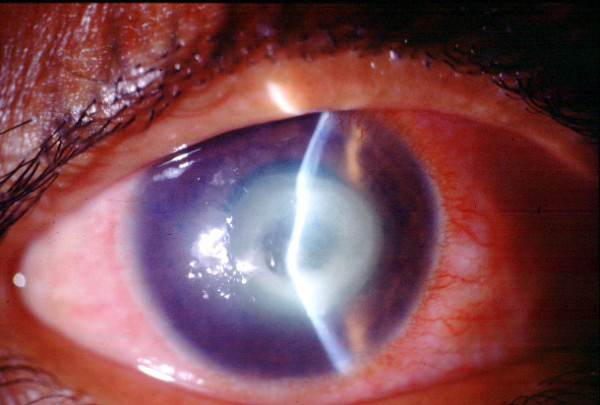
Slit lamp biomicroscopy of cornea of case 3 in diffuse illumination shows a large stromal infiltrate.